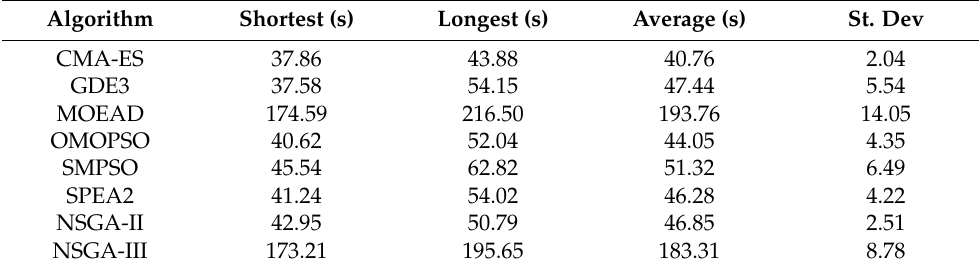
Table 6. Computational time of the NSGA-III in comparison with other evolutionary algorithms.